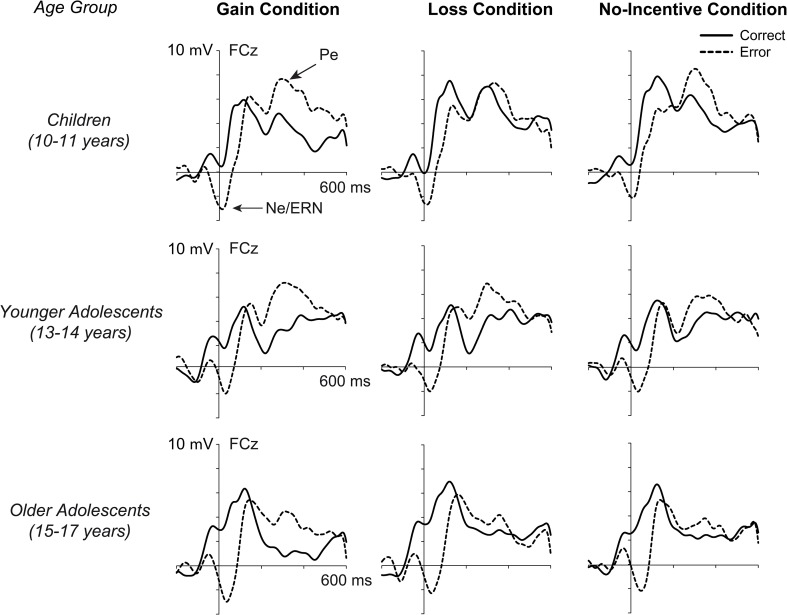
Response-locked grand average ERPs for the three incentive conditions, displayed separately for correct responses (solid lines) and incorrect responses (dashed lines), for children (top), younger adolescents (middle), and older adolescents (bottom) at electrode FCz.